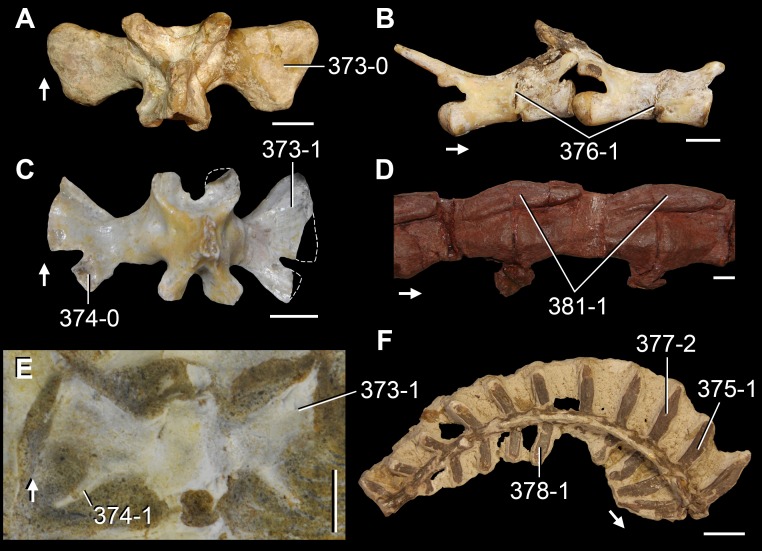
Sacral and caudal vertebrae and ribs of Triassic and Recent saurians in (A, C, E, F) dorsal and (B, D) right lateral views.(A) Second sacral vertebra of Tanystropheus longobardicus (SMNS 54631); (B) middle caudal vertebrae of Salvator merianae (MACN-He 47992); (C) second sacral vertebra of Mesosuchus browni (SAM-PK-6046); (D) distal caudal vertebrae of Herrerasaurus ischigualastensis (PVSJ 053); (E) second sacral vertebra of Rhynchosaurus articeps (SHYMS 5); and (F) anterior caudal vertebrae of Chanaresuchus bonapartei (PVL 4575). Numbers indicate character-states scored in the data matrix and the arrows indicate anterior direction. Scale bars equal 1 cm in (A, C, E, D), 4 mm in (B), and 2 cm in (F).